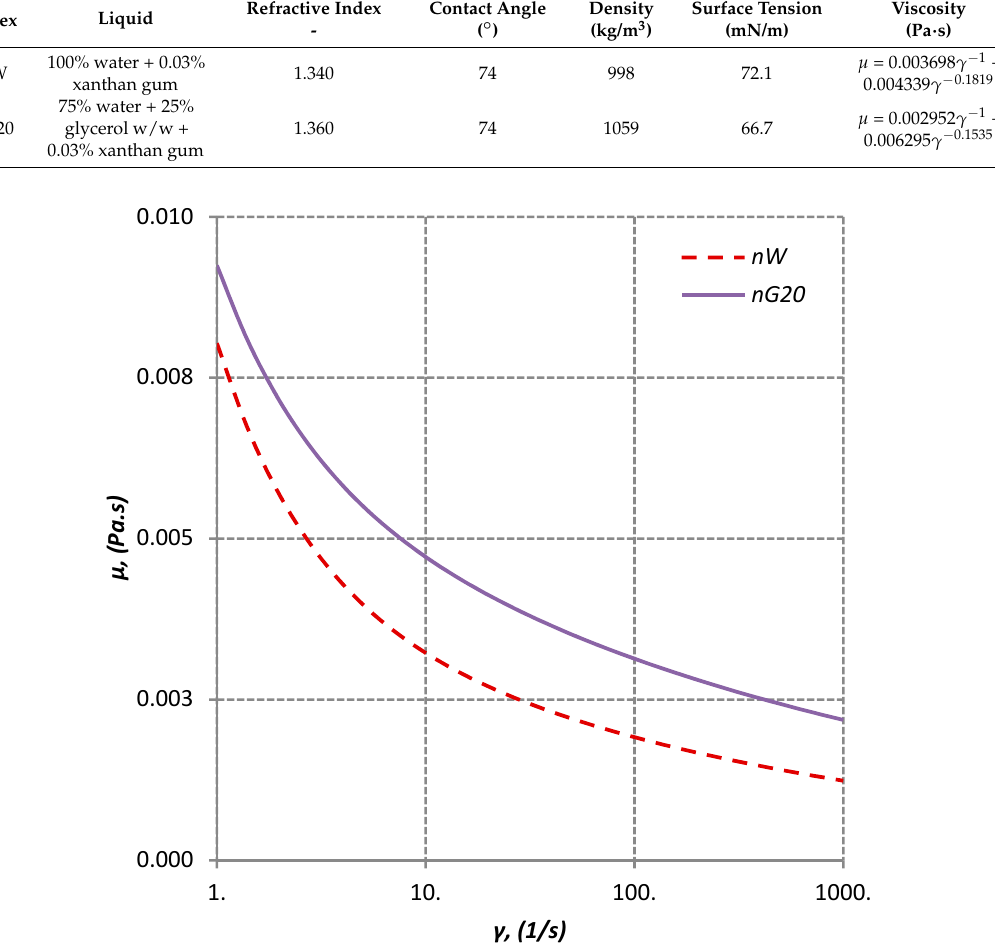
Figure 3. Viscosity curves of the two non-Newtonian liquids used.